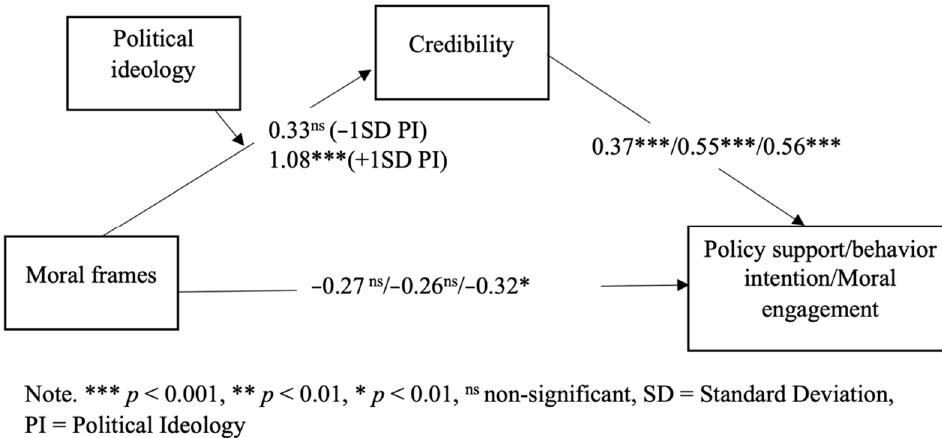
Figure 5. Moderated mediation model with unstandardized coefficients in the main study.